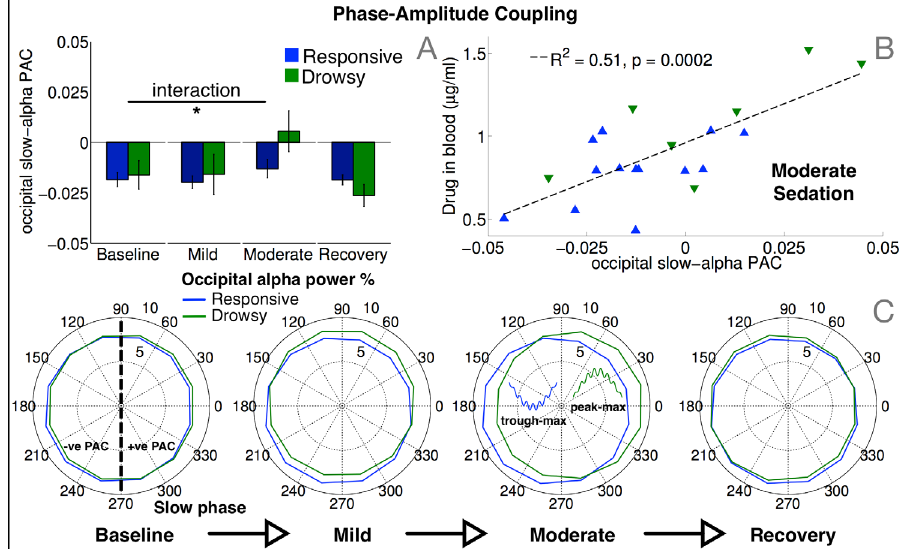
Fig 7. Phase-amplitude coupling (PAC) between slow and alpha oscillations. Coupling between ongoing slow phase and alpha power over occipital channels delineated in Fig 5A (top left) shifted from a trough-max to a peak-max (C) distribution in the drowsy group during moderate sedation, resulting in a significant interaction between group and sedation in PAC values (A). Crucially, these subject-wise PAC values significantly correlated with drug concentrations measured in blood across both groups during moderate sedation